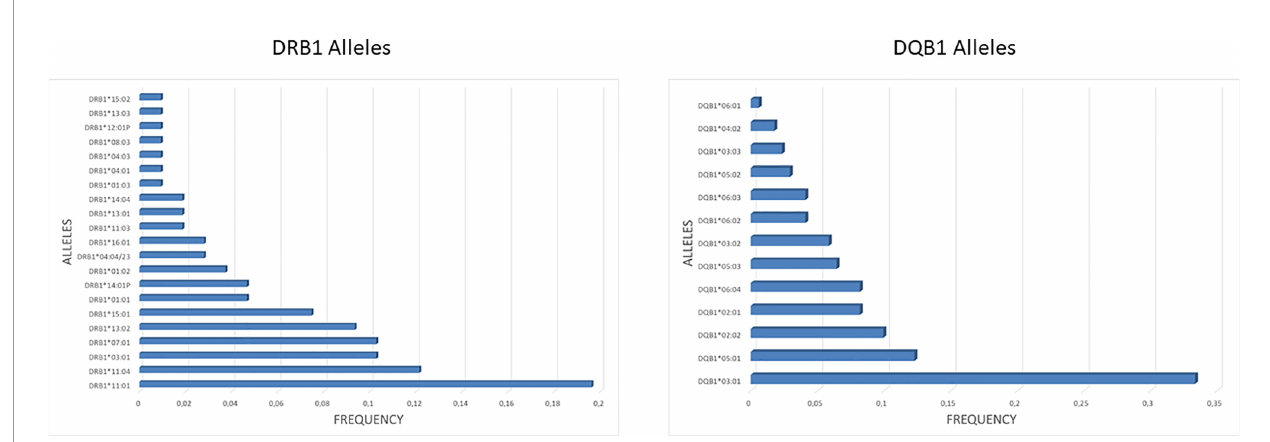
FIGURE 3 | HLA class II frequency in the cohort. The frequency of DRB1 and DQB1 alleles observed in the enrolled subjects is shown. For the DQB1 alleles is shown the cumulative frequency, taking into account all the observed combinations with DQA1 alleles.